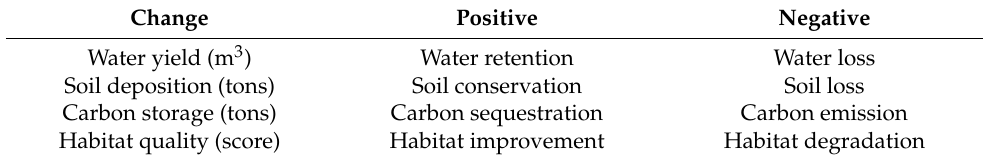
Table 3. The interpretation of temporal ES